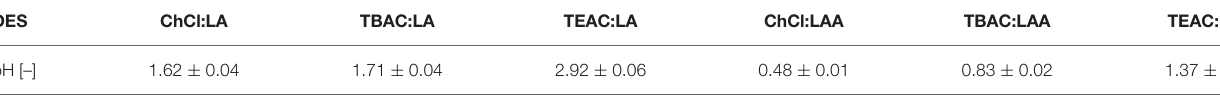
TABLE 3 | The pH values of the different DESs at 295K and 1 bar.